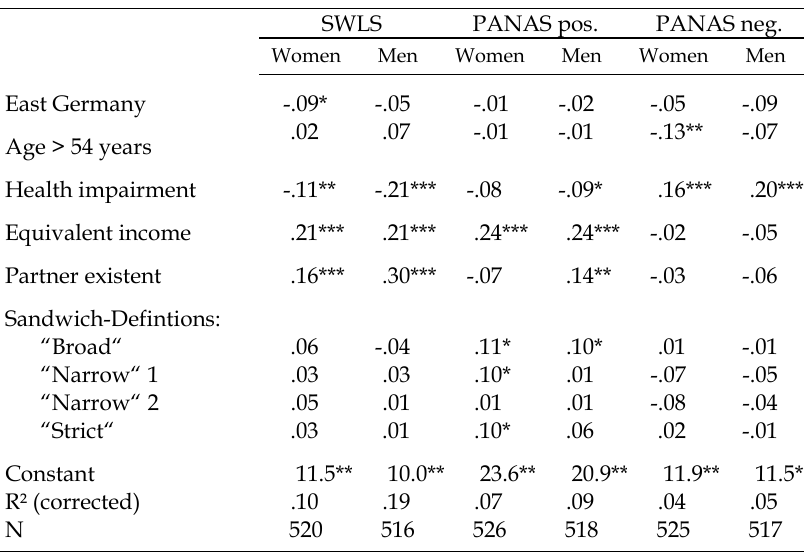
Table 1 . Satisfaction with life and positive and negative affect (OLS- regressions)